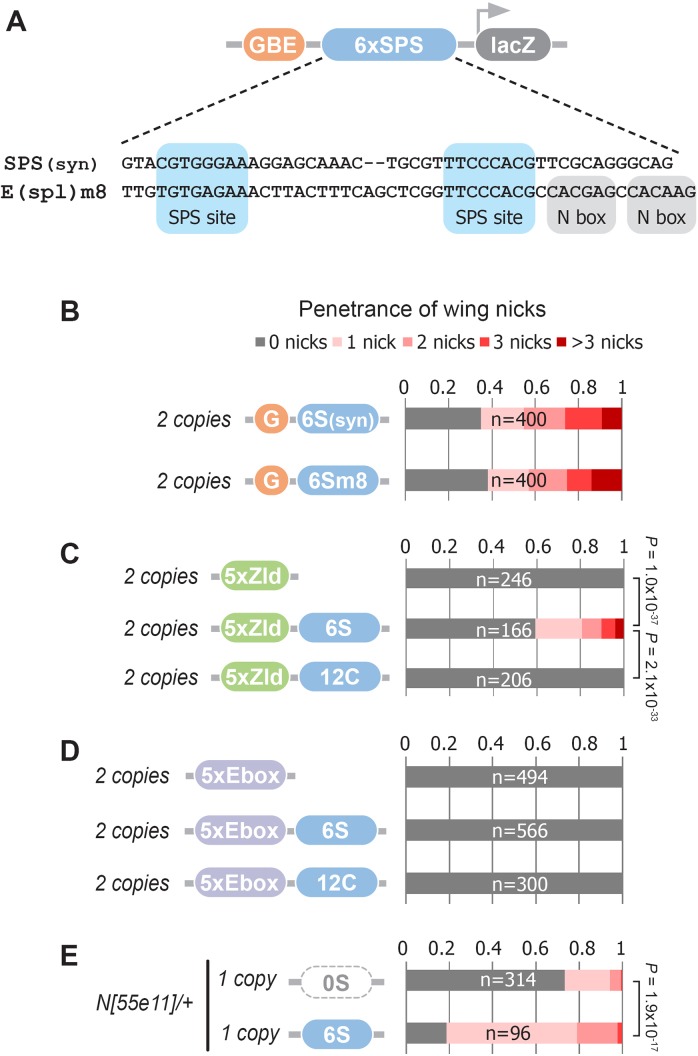
Defining enhancer TFBSs that induce the notched wing phenotype.(A) Graphical representation and sequence alignment of the synthetic SPS (SPS(syn)) and E(spl)m8 SPS constructs. SPS sites are highlighted in blue and Nbox sequences, which are only present in E(spl)m8, are shaded in gray. (B) Quantified wing notching in flies with two copies of either G6Ssyn-lacZ or G6Sm8-lacZ inserted in the same locus. (C) Quantified wing notching in flies with two copies of either 5xZelda(Zld)-lacZ, 5xZld-6xSPS-lacZ, or 5xZld-12xCSL-lacZ. Two-sided Fisher’s exact test assessed for significance between genotypes. (D) Quantified wing notching in flies with two copies of either 5xEbox-lacZ sites alone, 5xEbox-6xSPS-lacZ, or 5xEbox-12xCSL-lacZ. (E) Quantified wing notching in N heterozygous flies containing a single copy of either 0xSPS-lacZ or 6xSPS-lacZ transgenes. Proportional odds model tested for penetrance/severity.